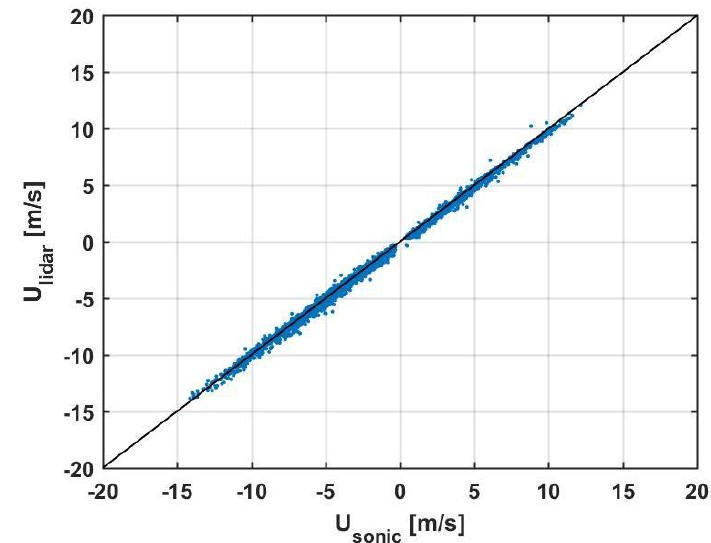
Figure 9. Correlation plot of ten-minute averaged velocities from 13 April 2015–11 June 2015. The coefficient of determination is R 2 = 0.9972 and the linear regression slope is